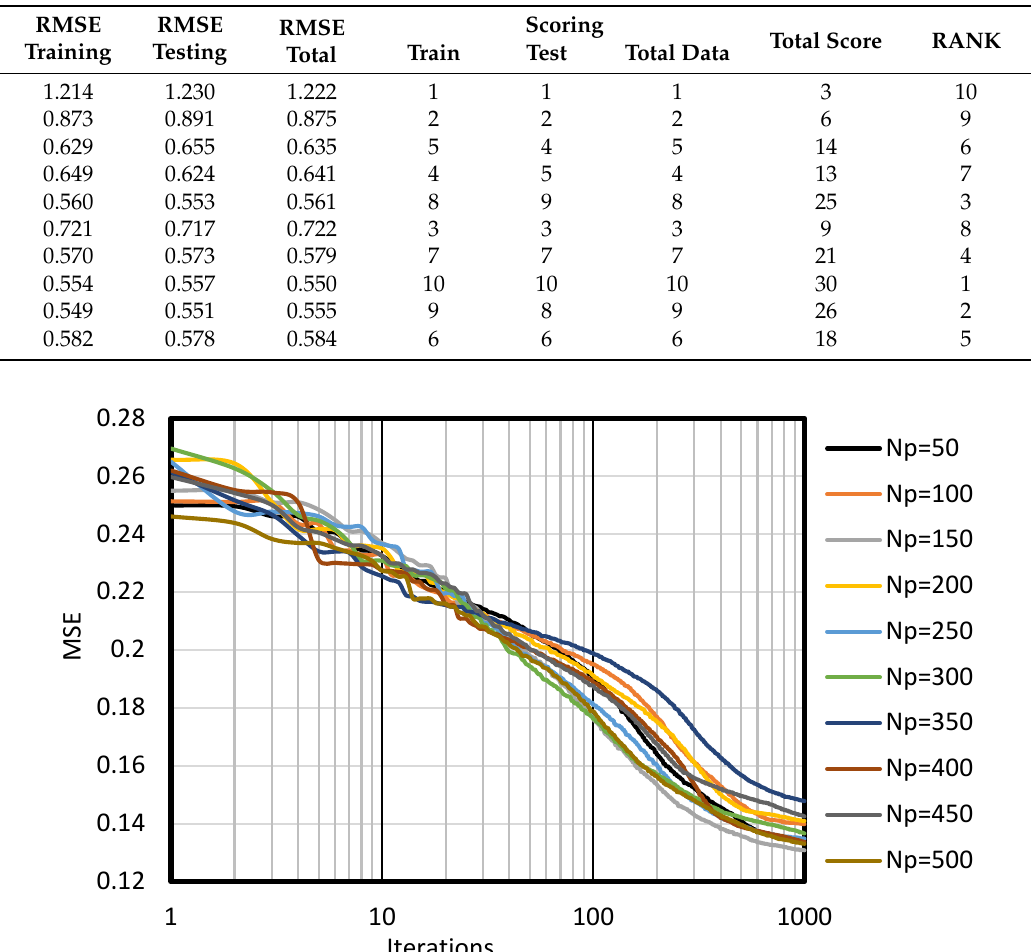
Table 2. Change in neuronal density as a predictor for landslide susceptibility mapping: sensitivity analysis.